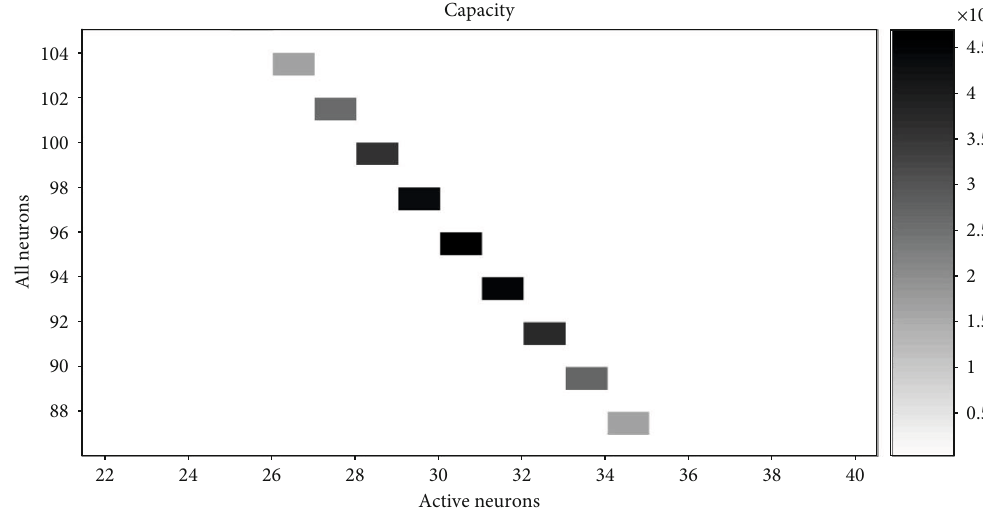
Figure 9: The representational capacity of di ff erent neural A small rectangular block in the fi gure represents neural networks with total energy cost between 154 and 156. The horizontal axis is the number of active neurons in the net- work; the vertical axis is the total number of neurons in the network. The color of the small rectangle indicates the representational capacity of the network. Black means large representational capacity, and white color means small representational capacity. The case that corresponds to the maximum representational capacity is N = 103 , A = 33 , and p = 33/103 = 32 : 0 % .